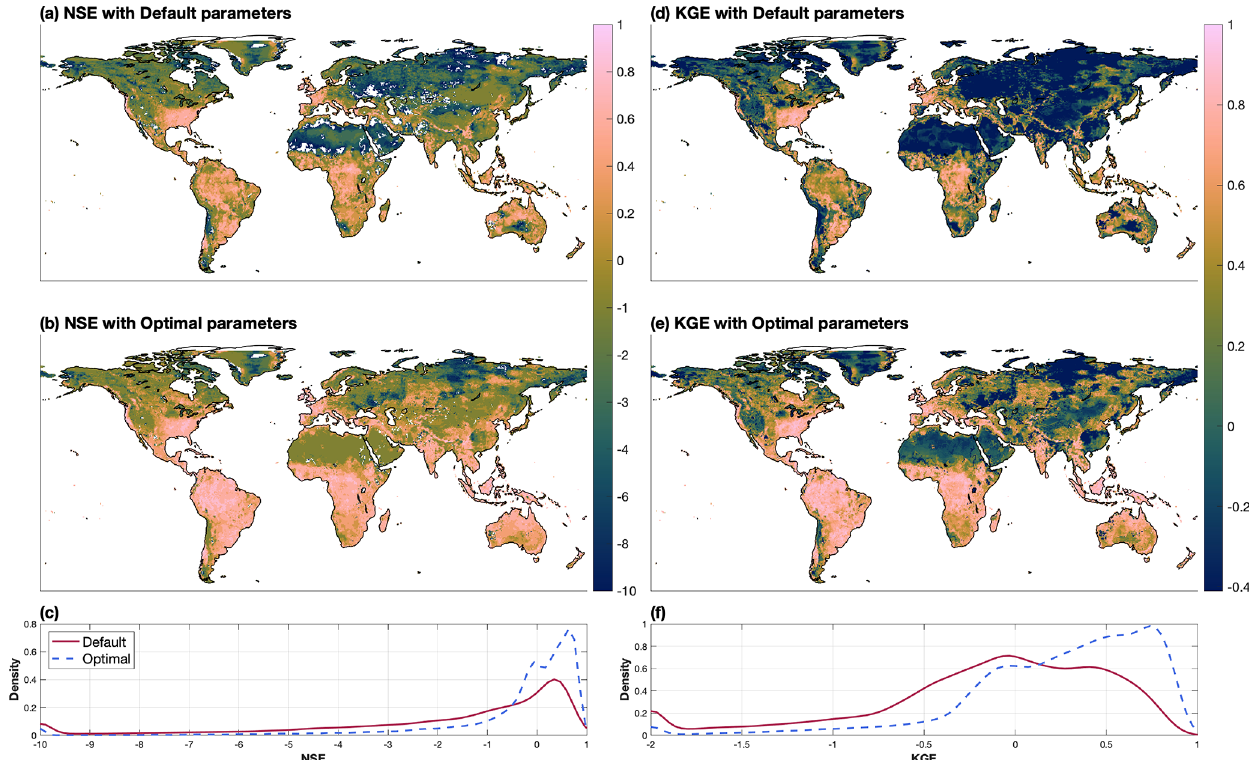
Figure 8. Evaluation of simulated monthly runoff for 1991–2010 at grid level with default and optimal parameters. Panels (a) and (b) show the NSE metrics between the GRUN runoff and simulated runoff with default and optimal parameters, respectively. Panel (c) shows the comparison of the probability density function (PDF) of NSE metrics from all the global grid cells. Panels (d) , (e) , and (f) illustrate the evolution with the KGE